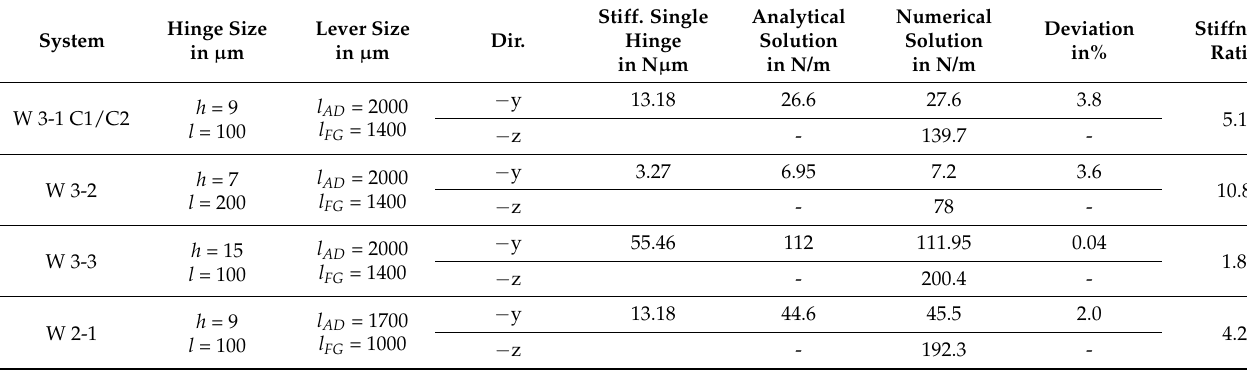
tensor: σ 11 = σ 22 = σ 33 = 1.66 × 10 5 MPa, τ 21 = τ 31 = τ 32 = 64,000 MPa) was used directly from the